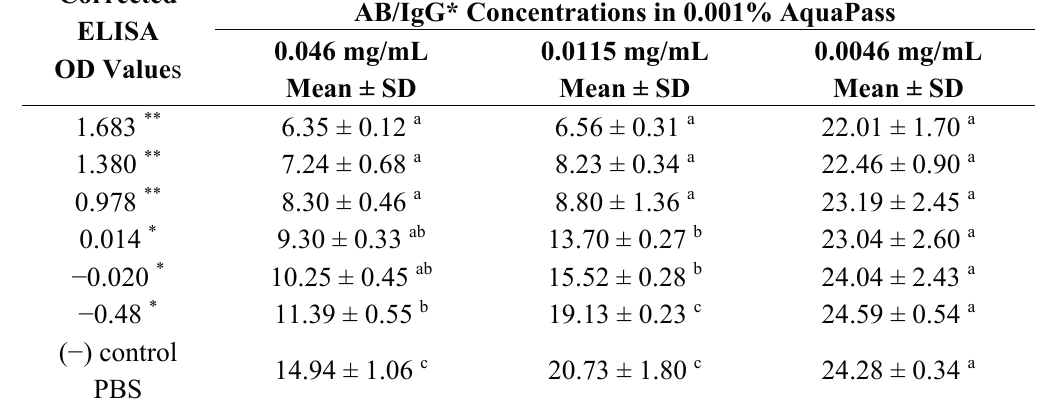
Table 1. Results of conductometric biosensor analysis of bovine serum samples at different concentrations of anti-bovine IgG conjugated with polyaniline.